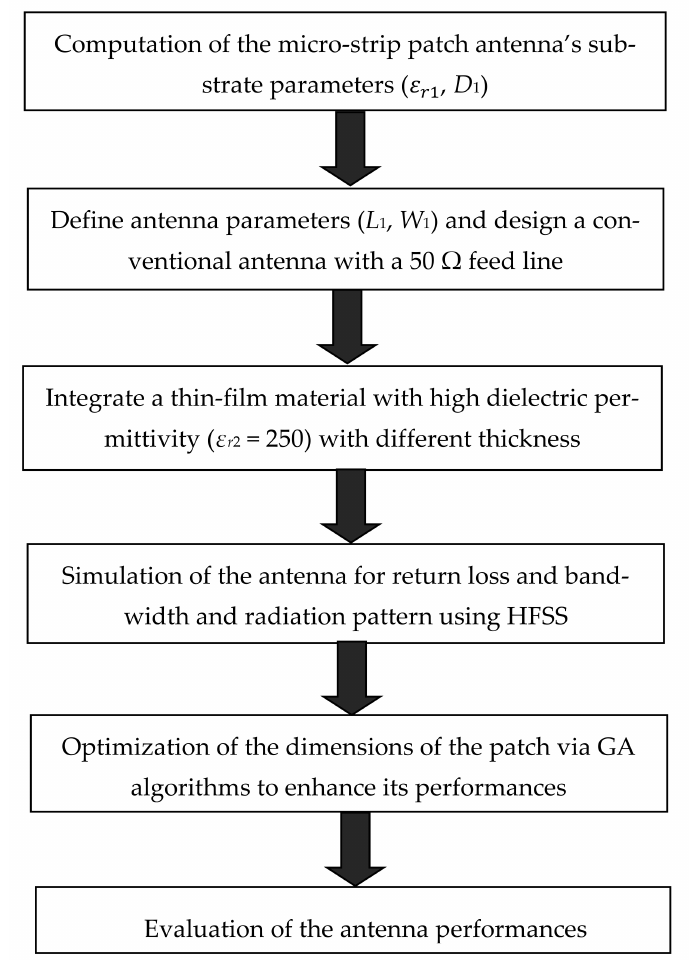
Figure 1. Flowchart of the antenna design